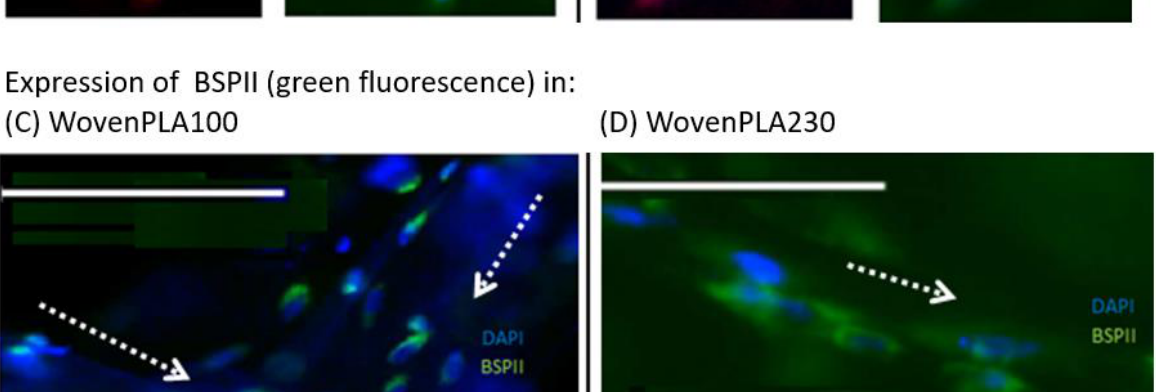
Figure 7. In vitro expression of OCN and BSPII in MG 63 cells, after 21 days of cell culture. ( A , B ) show expression of OCN in MG 63 cells adhered onto WovenPLA100 and WovenPLA230, respectively. The nuclei were stained with DAPI (in blue), actin labelled with phalloidin (in red), and OCN stained in green; ( C , D ) show expression of BSPII in MG 63 adhered onto WovenPLA100 and WovenPLA230. The nuclei were stained with DAPI (in blue), BSPII were stained in green. (For all images, white scale bars = 100 µ m. White dotted arrows indicate filament length